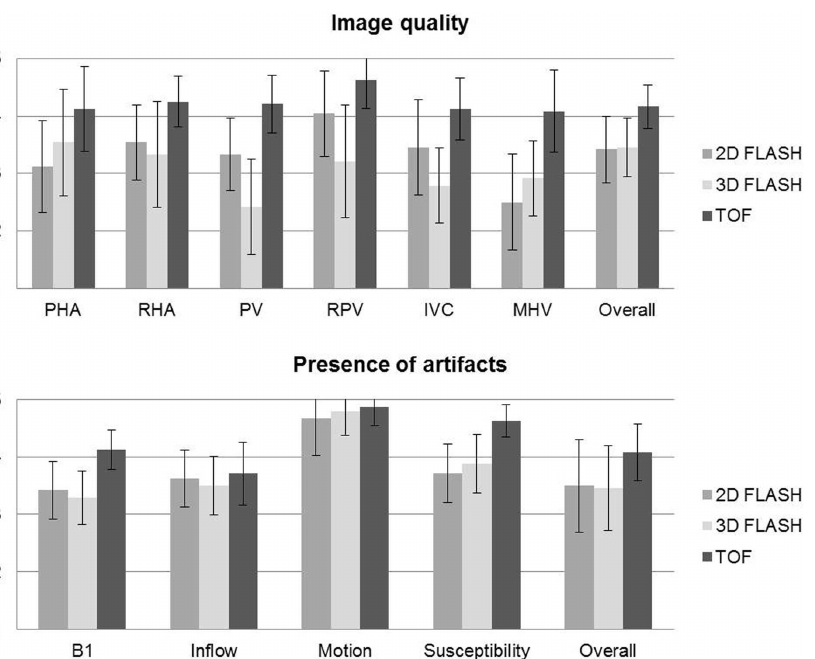
Figure 2. Qualitative analysis of image quality and presence of artifacts (5-point scales) for all analyzed liver vessel segments in all three sequences. (PHA = proper hepatic artery, RHA=2 nd order branch of right hepatic artery, PV = main portal vein, RPV=1 st order branch of right portal vein, IVC = inferior vena cava, MHV = middle hepatic vein).